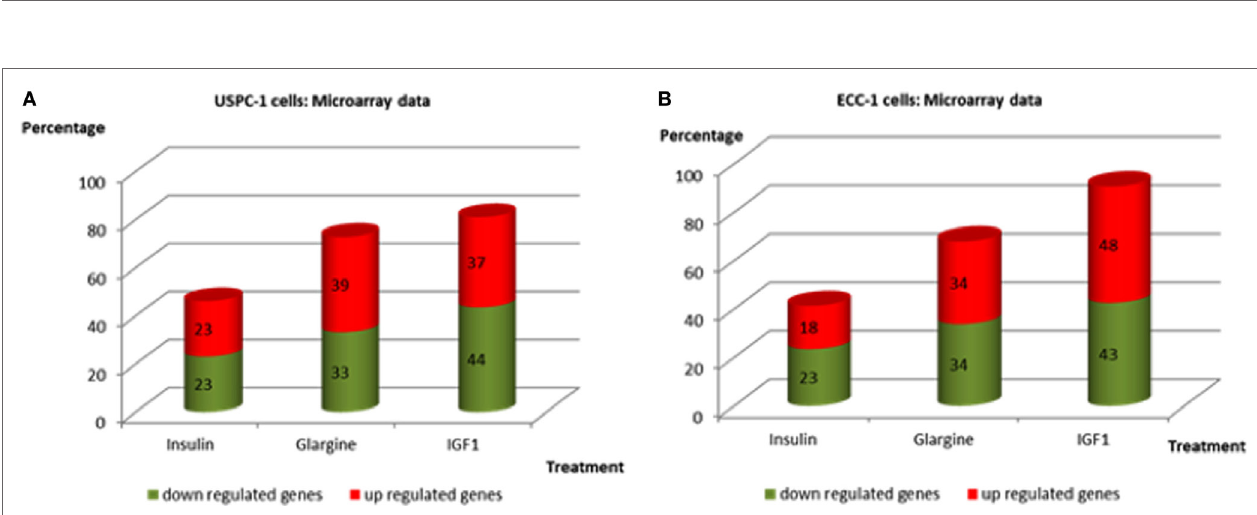
FigUre 6 | Venn diagrams showing the number of differentially expressed genes in response to glargine, insulin, or IGF1 in USPC-1 cells. (a) Number of total genes induced after IGF1, glargine, or insulin treatment; (b) number of genes up-regulated; (c) number of genes downregulated. The Venn diagram shows the number of genes uniquely expressed after response of the indicated treatment. The intersection of the circles shows the number of genes commonly expressed. The genes included in this analysis showed a 1.5-fold change in the expression compared to the